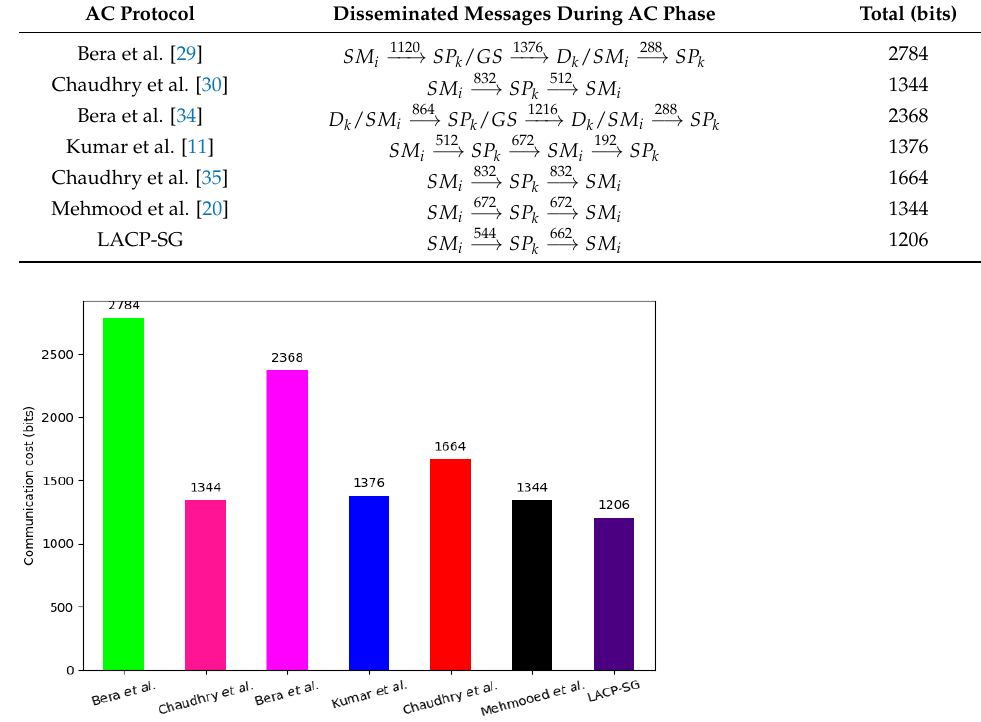
Figure 5. Communication cost needed to perform the AC phase (single SM i ) [11,20,29,30,34,35].